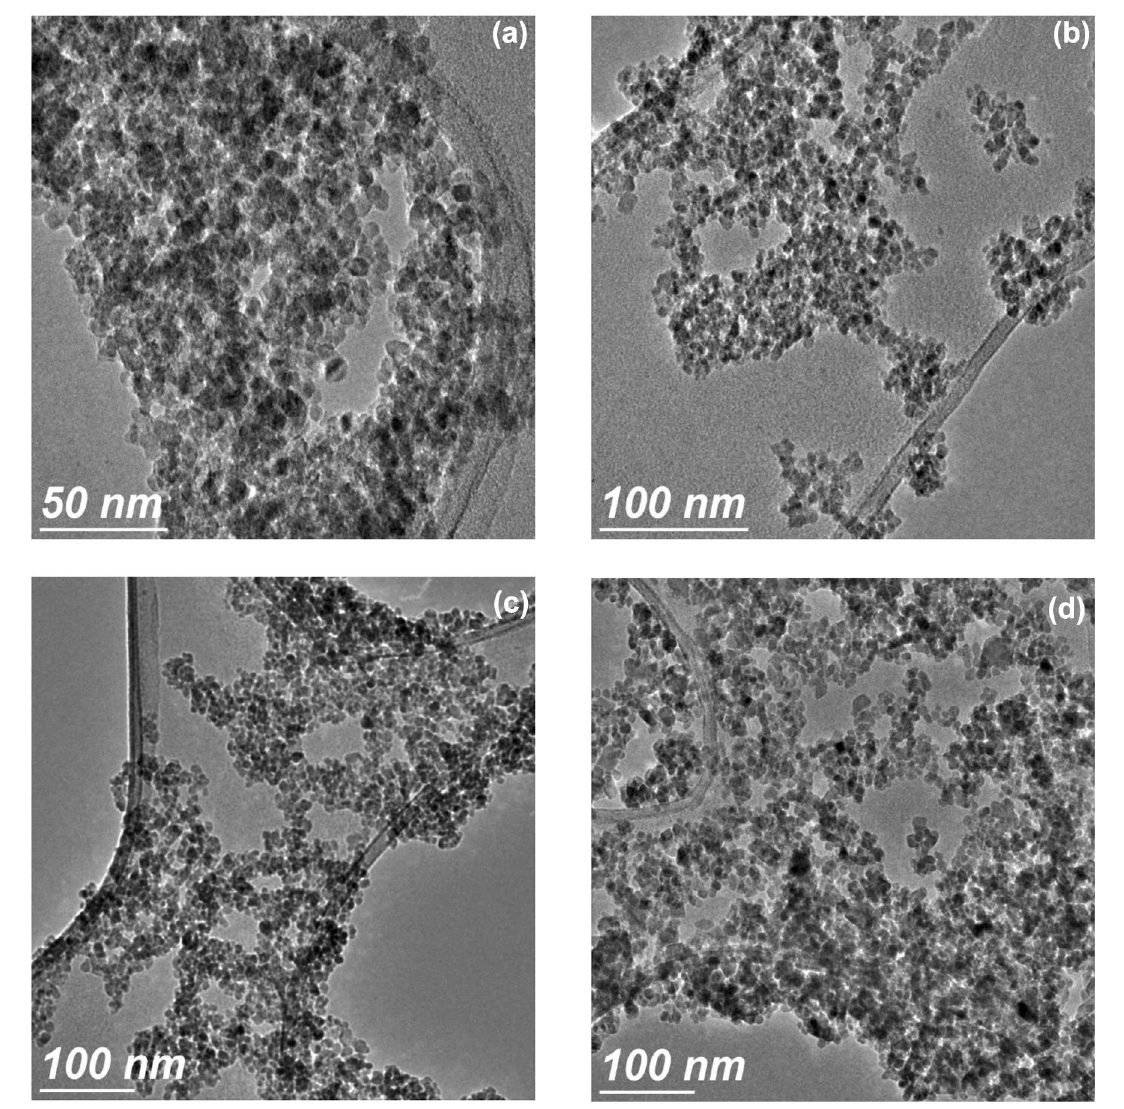
Fig. 3 TEM image of TiO 2 samples prepared by hydrothermal at a 120 °C, b 150 °C, c 200 °C, and d 250